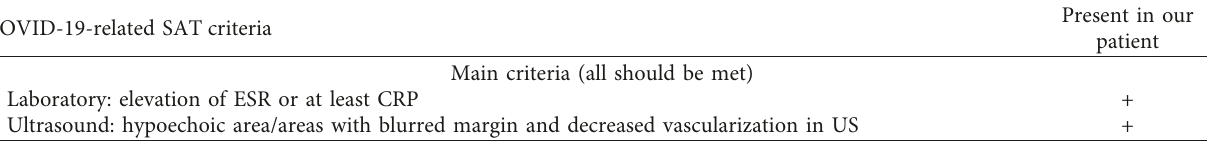
Table 3: Comparison the mentioned criteria with the clinical findings of our